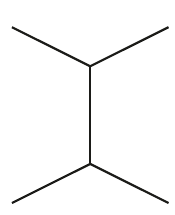
Figure 15 . Additional Feynman diagram required to study O ( a 2 ) discretization effects in the AA channel for twisted-mass